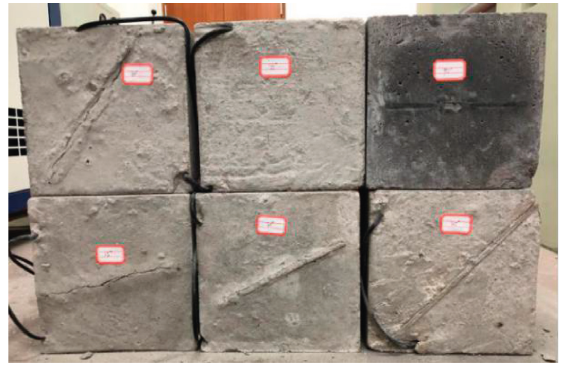
Figure 13: Multiangle test model.